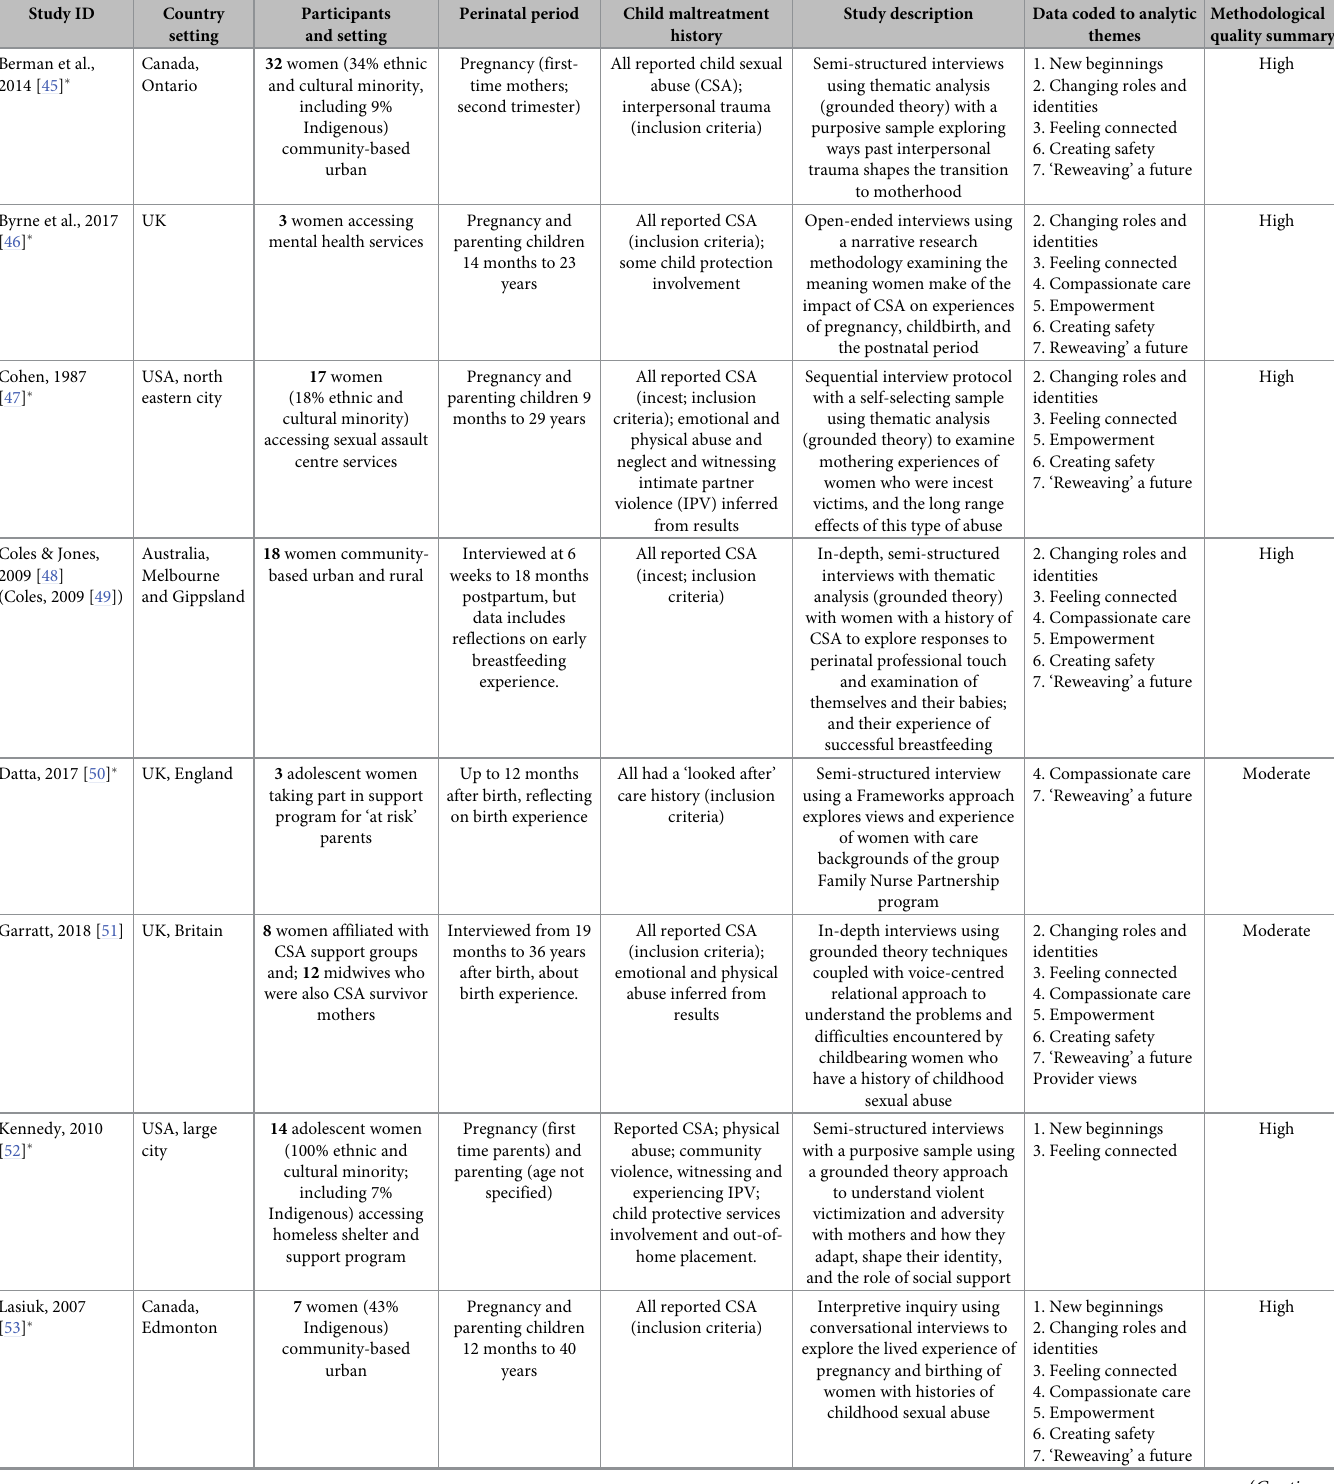
Table 1. Characteristics of included